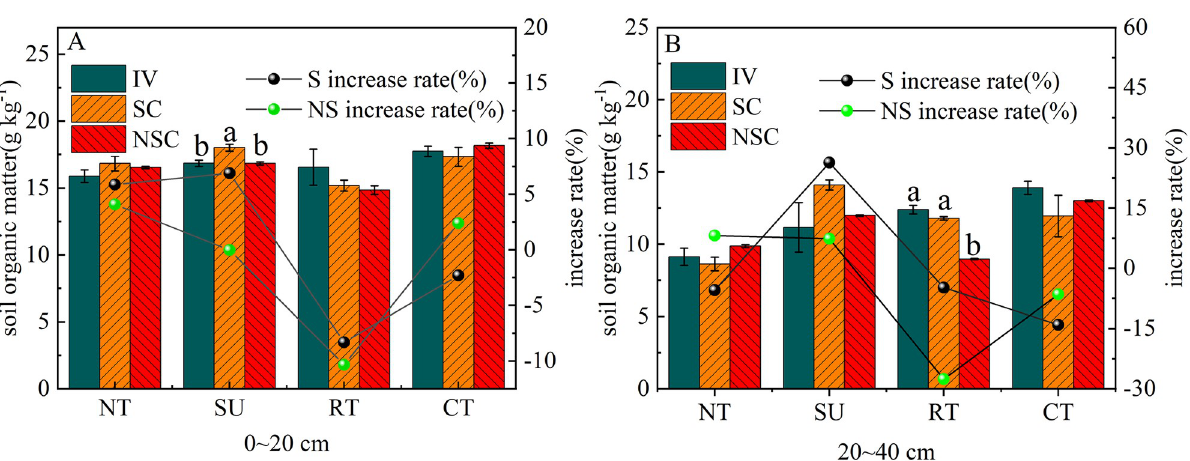
Fig 7. Variation of SOM in different tillage cultivations and soil layers. Note: IV, SOM content in 2016; S, SOM content in 2020 with straw return; NS, SOM content in 2020 with straw removal; SC: Straw cover return; NSC: No straw cover return. The left coordinates represent the comparison of SOM content between the starting year of the positioning experiment and after five years of a continuous cultivation. The right coordinates represent different treatments and the increase in SOM compared with the starting year of the positioning experiment.